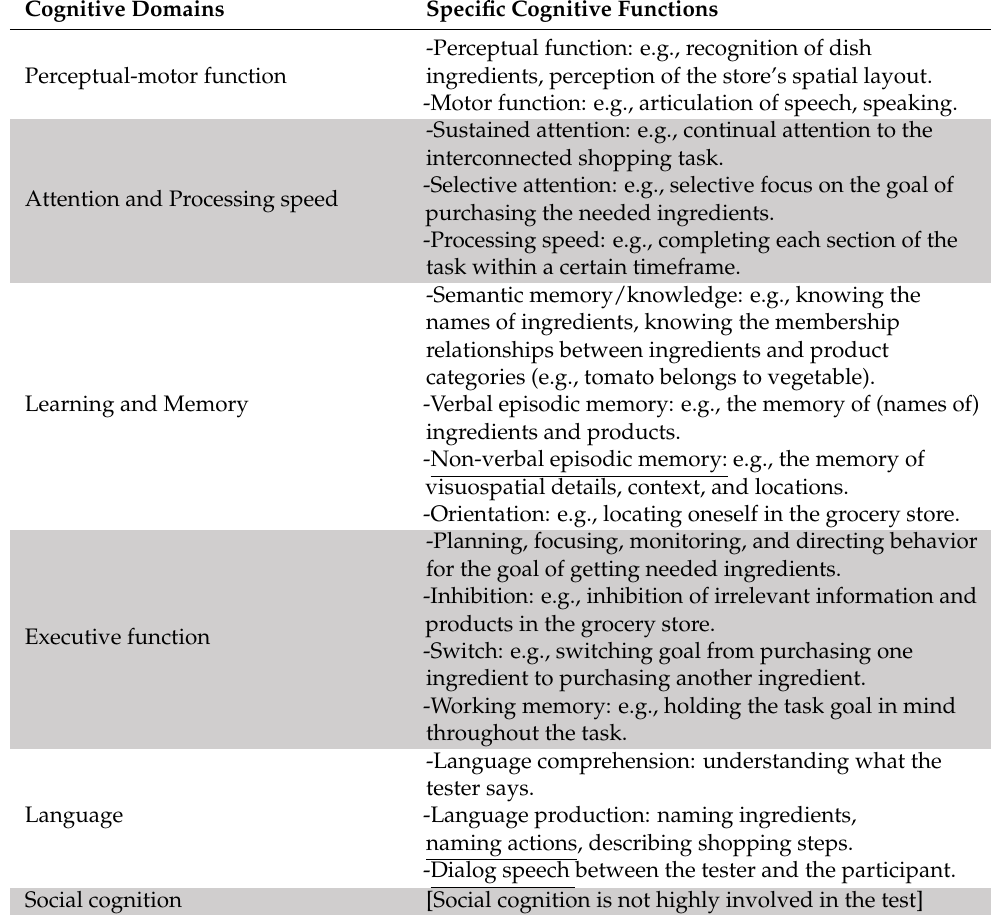
Table 1. Cognitive functions involved in the Hong Kong grocery shopping dialog test